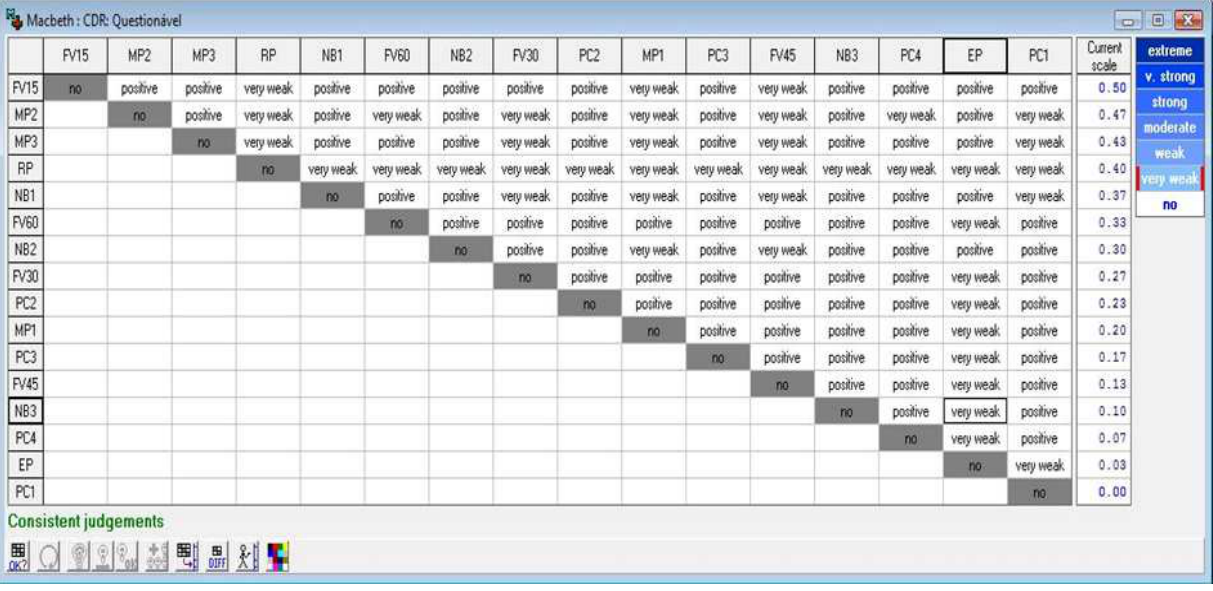
Fig. 3. Matrix of judgment of value and scale for the FPV1 - CDR: